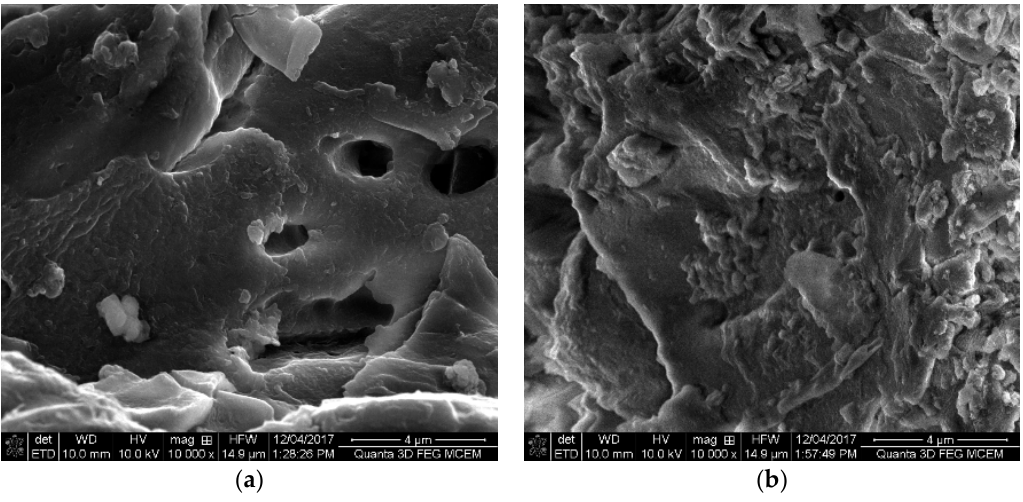
Figure 3. Scanning electron microscopy (SEM) images of ( a ) unsaturated and ( b ) water-saturated samples (Images taken under accelerated voltage of 10 kV, 47 pA probe current and magnification of 10,000×; unsaturated sample exhibit a much smoother surface with larger pores while water saturated sample shows a relatively lumpy surface with small pores).